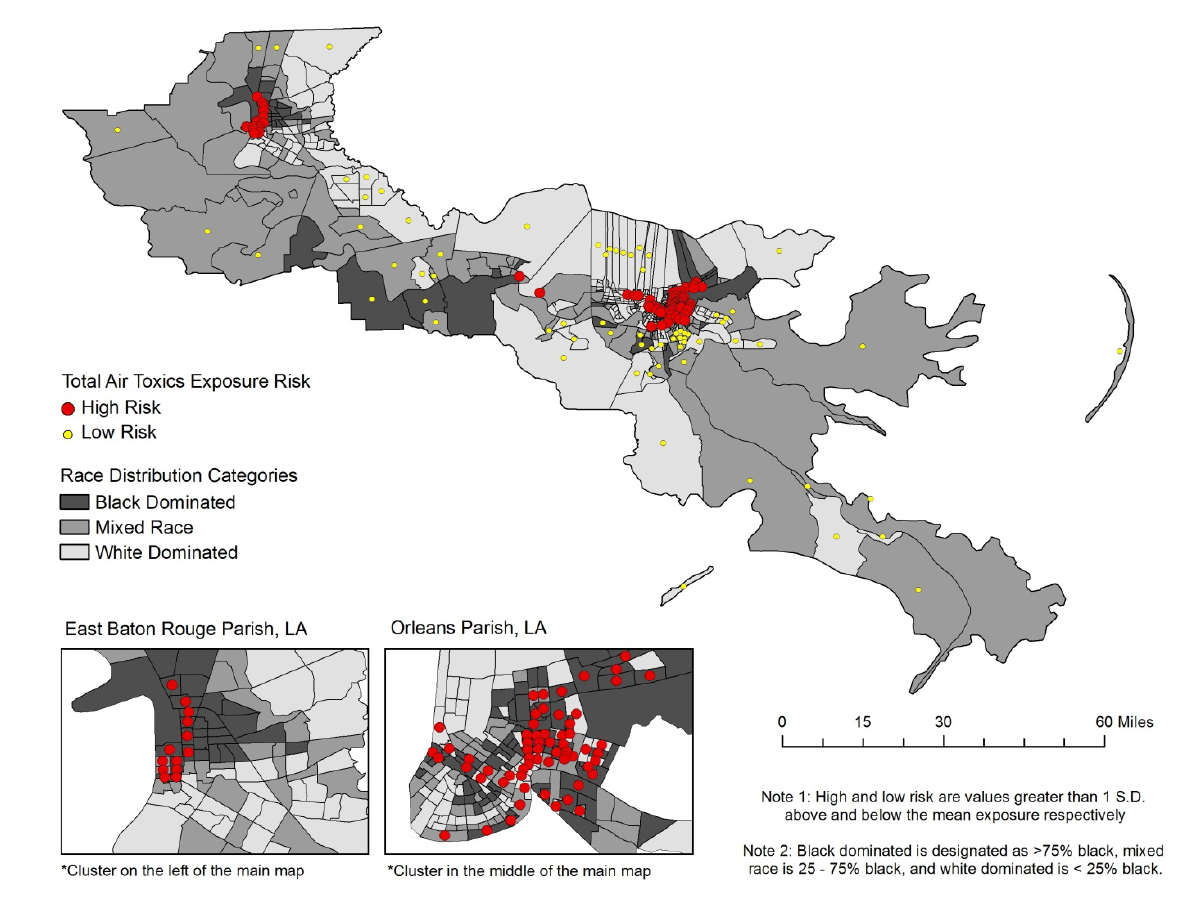
Figure 4. The cumulative risk from all toxics by race in Cancer Alley